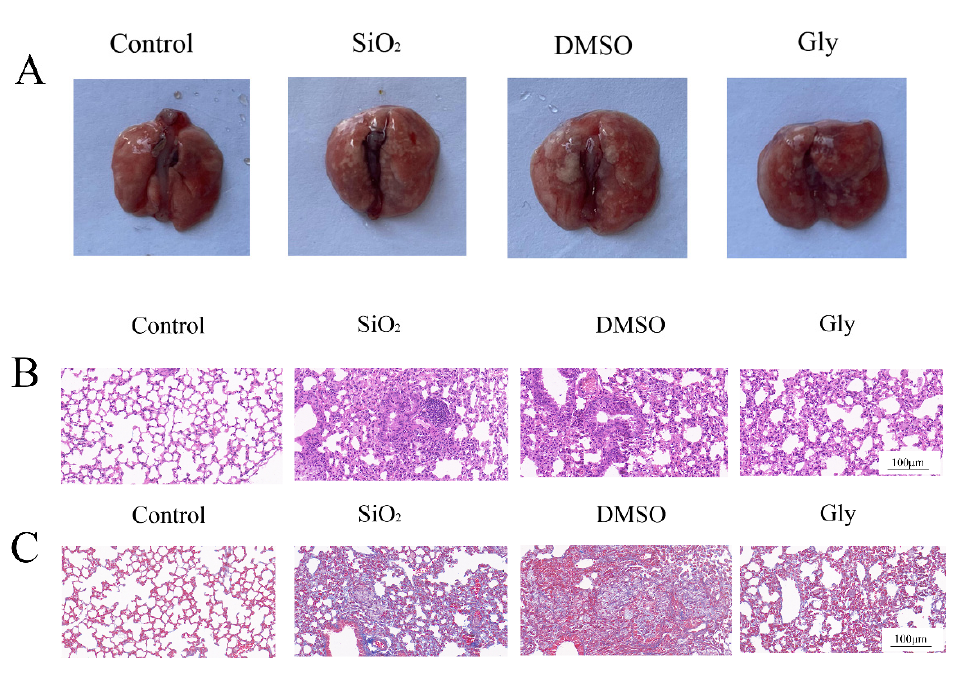
Figure 6. Protective effect of glycyrrhizic acid on pulmonary fibrosis in mice. ( A ) Morphological observation of the lung. ( B ) Hematoxylin–eosin (HE) of lung tissue sections in mice. ( × 200). Scale bar = 100 µ m. ( C ) Masson staining of lung tissue sections in mice. ( × 200). Scale bar = 100 µ m.